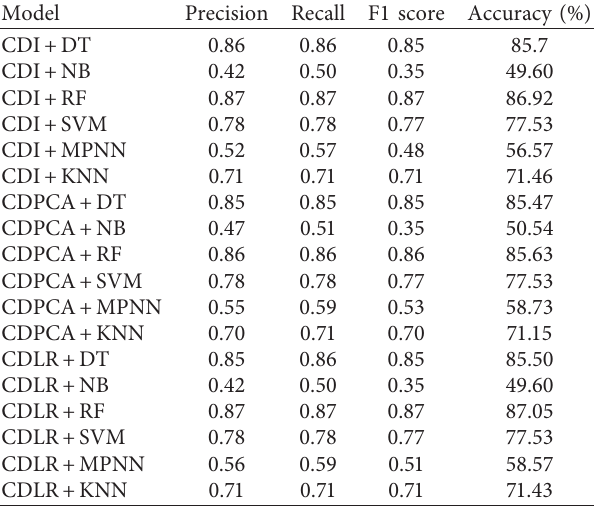
Table 11: Results for the multiclass classification with cross vali- dation with N � 10. Model